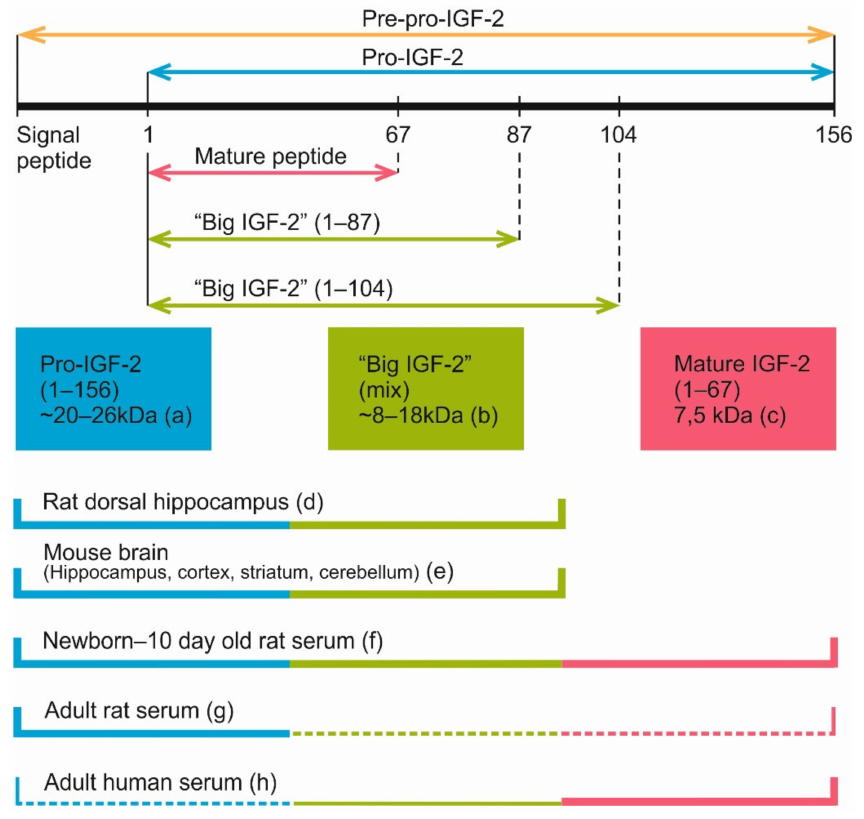
Figure 6. Currently known IGF-2 proteolysis sites and IGF-2 proteoforms discovered in blood serum and brain samples of different species. ( a ) According to various reports, pro-IGF-2 (1-156 aa) has a molecular weight about 20–26 kDa in different tissues [36,107,108]. ( b ) Proteoforms 1–87 aa and 1–104 aa, also known as “big IGF-2”. A few products of incomplete pro-IGF-2 cleavage weighing from 8 to 18 kDa were registered in some experiments [35,36,106,112]. ( c ) Mature IGF-2 (1-67 aa) has a molecular weight of 7.5 kDa [7,54,106,109,110]. ( d ) 15 and 20 kDa IGF-2 proteoforms were found in rat dorsal hippocampus [108]. ( e ) 14 and 21–22 kDa IGF-2 proteoforms were detected in mouse brain regions (hippocampus, cortex, striatum and cerebellum), with some additional bands being present on Western blots [111]. 17 kDa IGF-2 was found in mouse hippocampus and entorhinal cortex [20]. (f) Mature IGF-2, “big IGF-2” and pro-IGF-2 are present in the serum of neonatal [54] and 10 days old rats [112]. ( g ) In the serum of adult rats, pro-IGF-2 is the predominant proteoform, while mature and “big” IGF-2 are either present in low quantities [54] or not detected at all [112]. ( h ) Mature IGF-2 (7.5 kDa) is the main IGF-2 proteoform in adult human serum (plasma) [54,110,112], while “big IGF-2” is present there in low quantity [110,112]. Pro-IGF-2 was also revealed in the human serum in some studies [112] but not detected in others [54,110]. Thick lines denote proteoforms that were clearly present in samples, thin lines denote proteoforms that were reported to be present in low quantity, dash lines denote proteoforms that were detected only in some of all the referenced